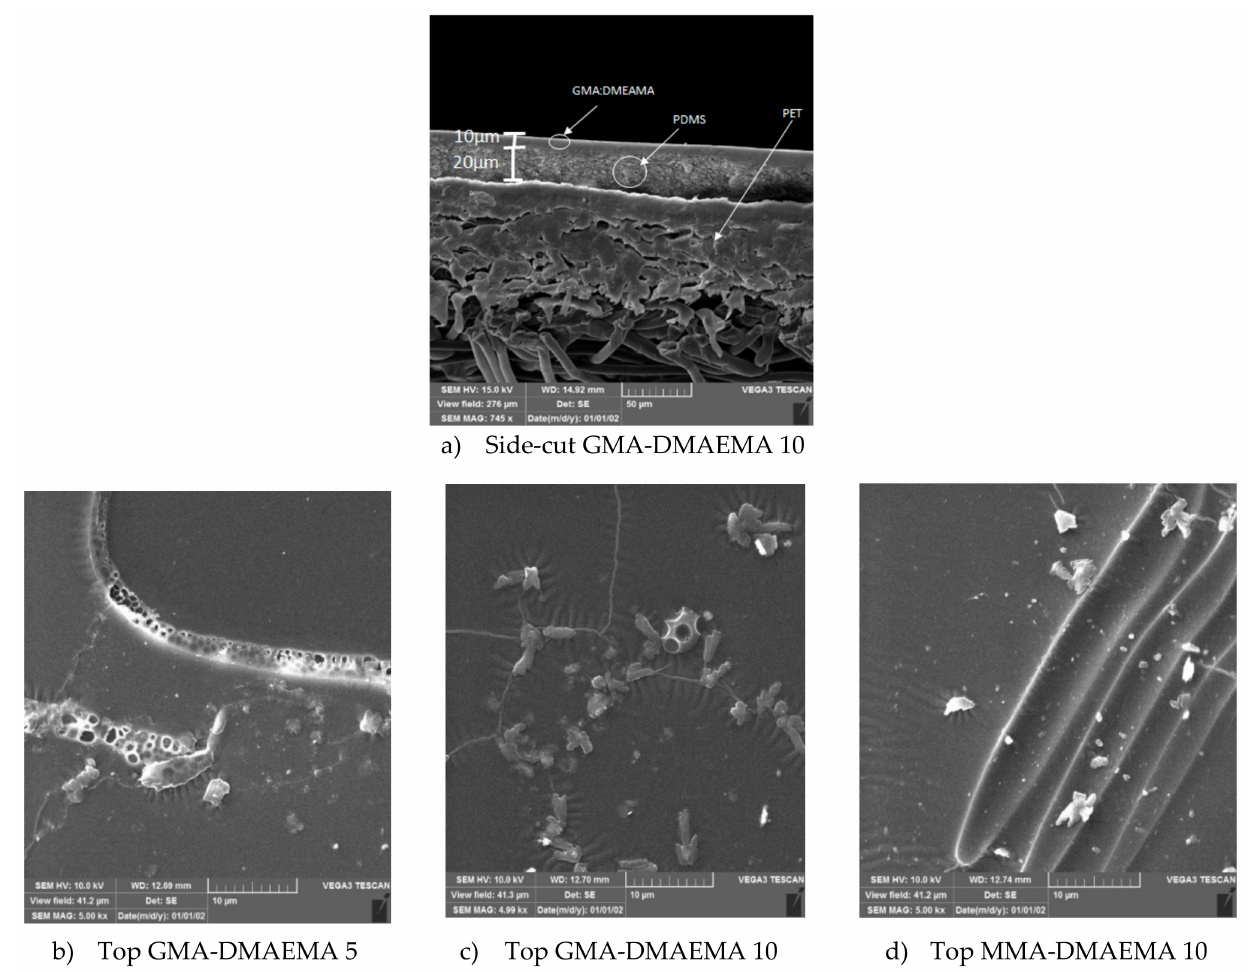
Figure 3. Side-cut and top surface Scanning Electron Microscopy imaging of modified GMA-DMAEMA and MMA- DMAEMA